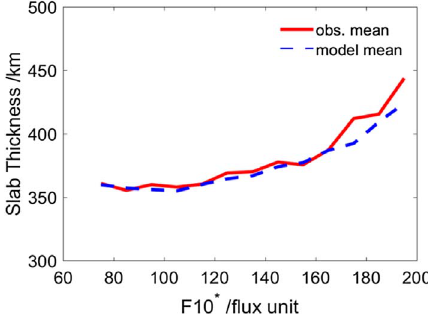
Fig. 2. Equivalent slab thickness as a function of solar activity ( F 10 index).